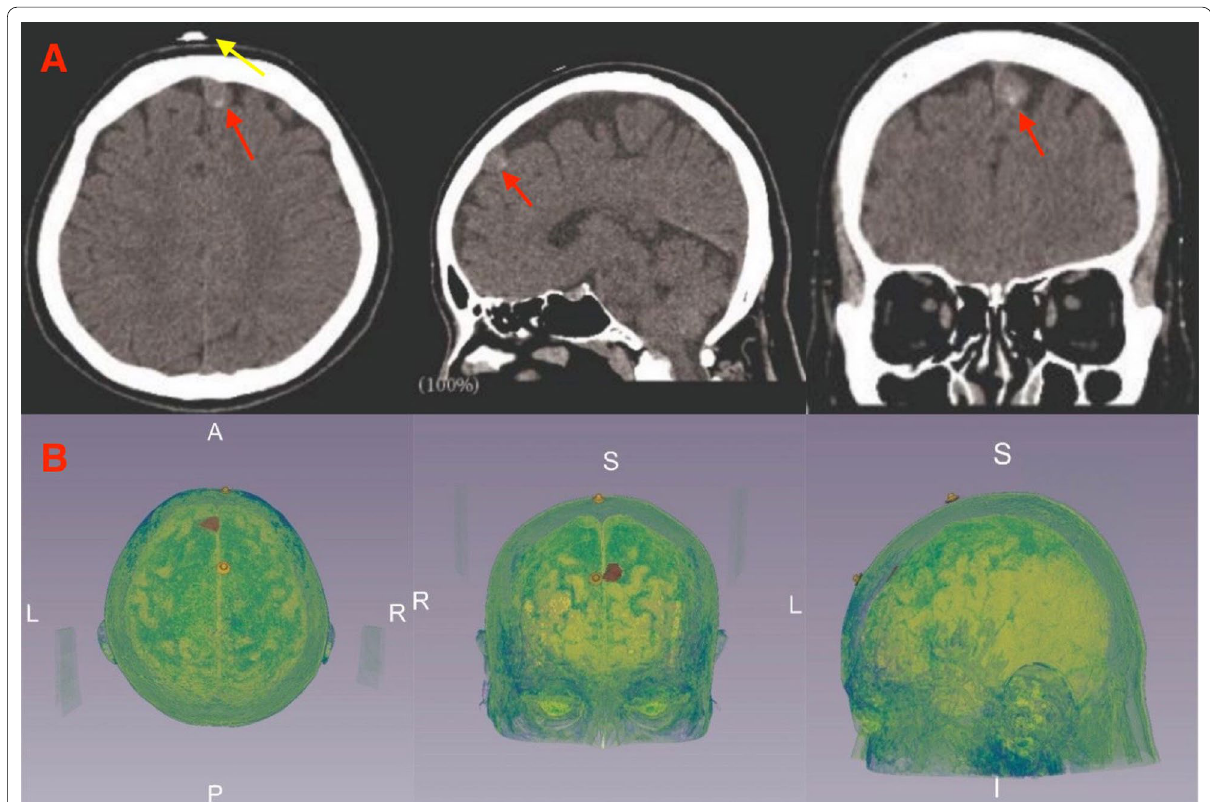
Fig. 2 A The data obtained from the thin-layer CT scan before the operation can see the tumor and the electrode piece. B The CT-Fat sequence reconstructed with the volume reading tool can display the tumor, marker, and its surrounding anatomical structure completely. The yellow arrow shows the position of marker and the red arrows show the tumor’s position. A anterior, P posterior, S superior, I inferior, L left, R